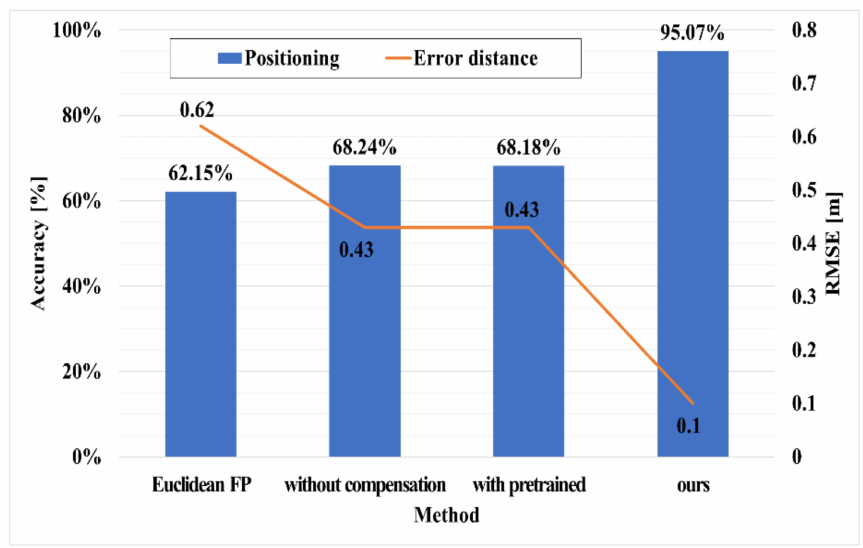
Figure 10. Accuracy and RMSE results according to each network frame.